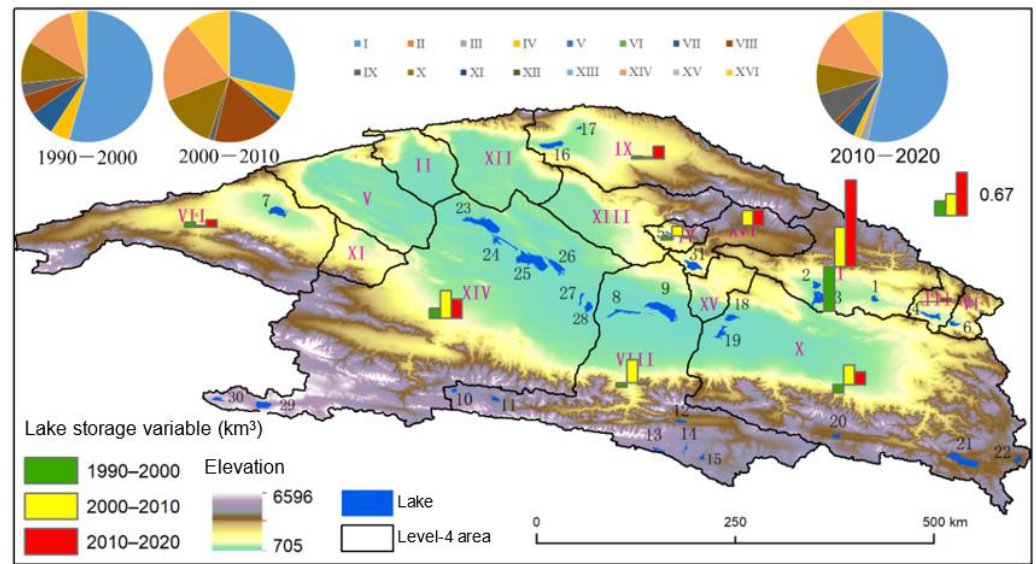
Figure 5. Spatial pattern of the lake storage variable in the Qaidam Basin from 1990 to 2020. Green, yellow, and red histograms represent the lake storage variable for different decades in each WRZ, with a scalar in the upper right corner.